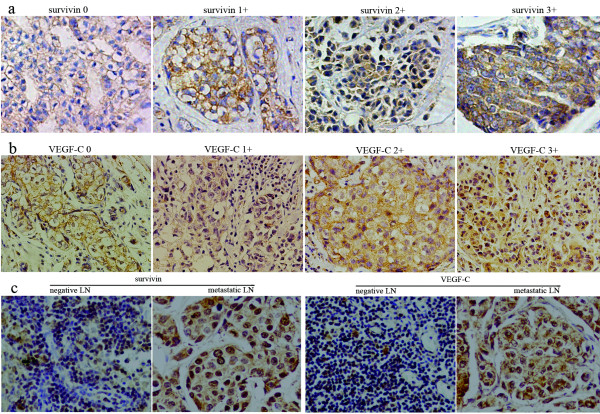
Results of immunohistochemical staining of breast cancer tissue and lymph node.a shows survivin expression in the order of degree 0-3+ in breast cancer tissue; b shows VEGF-C expression in the order of degree 0-3+ in breast cancer tissue; c shows survivin and VEGF-C expressions in negative and metastatic lymph node respectively(200×).